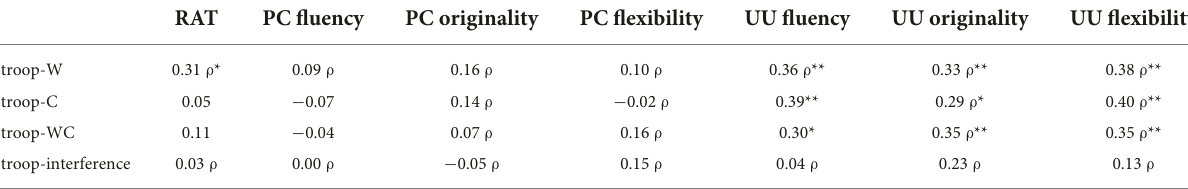
TABLE 5 Baseline correlations between Stroop scores and divergent thinking (DT) and convergent thinking (CT) tasks.